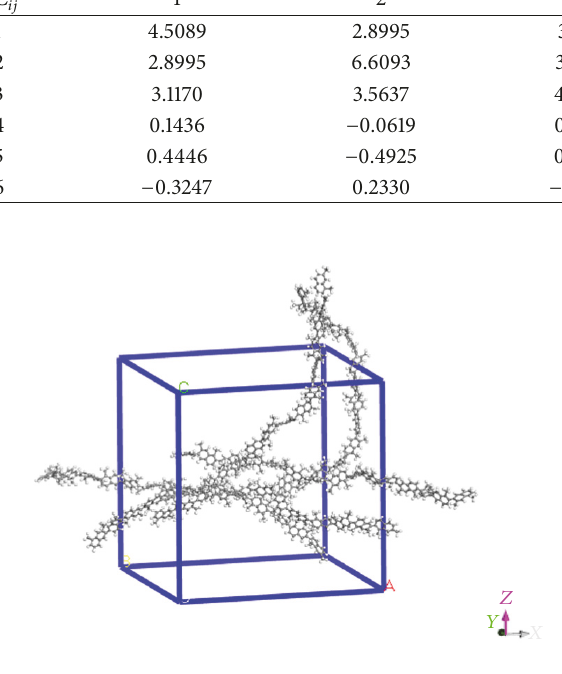
Figure 8: Ultimately obtained colloid system.